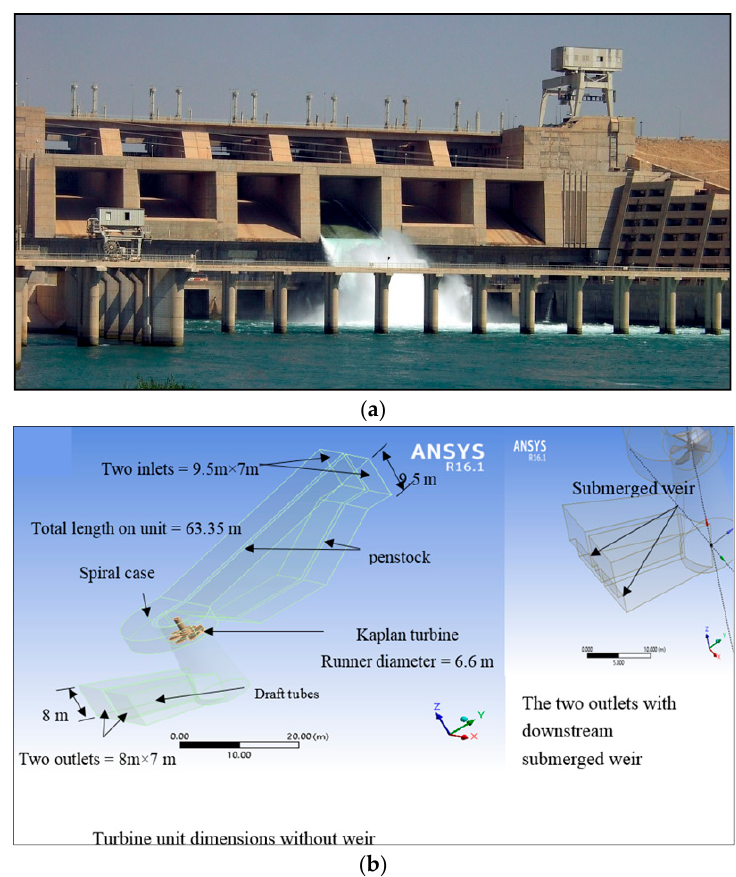
Figure 2. ( a ) Downstream of Haditha dam with a spillway and power station outlets, and ( b ) visualization of the 3-D model of the vertical Kaplan unit with full dimensional details.